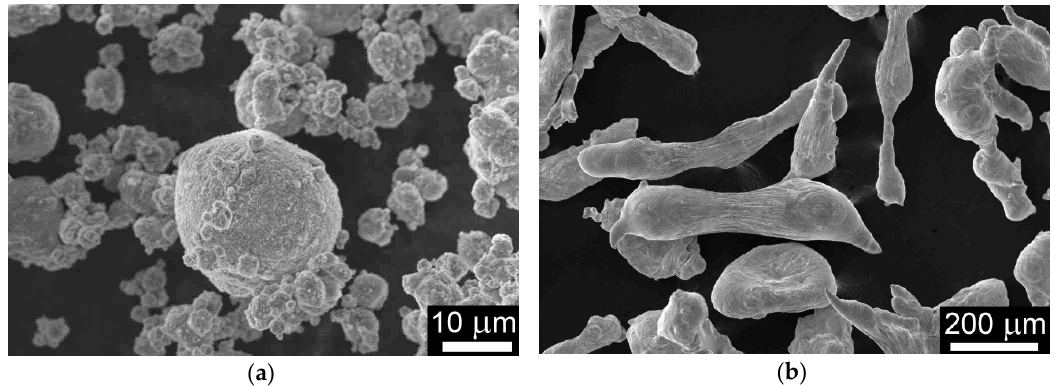
Figure 1. Zn particles, SEM (scanning electron microscope): ( a ) Mean particle size 7.5 µm; ( b ) mean particle size 150 µm.